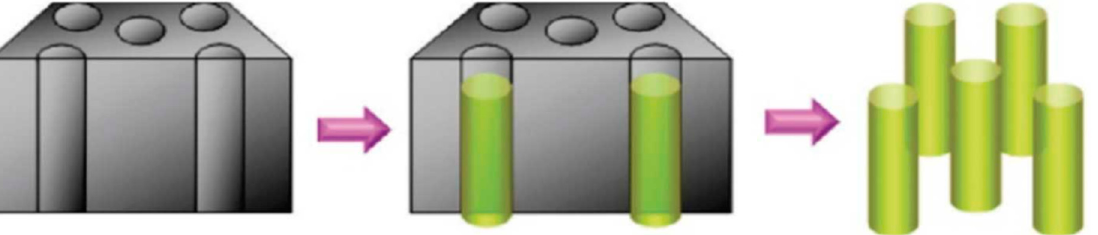
Figure 3. A schematic illustration of the growth process of nanowires via a hard template. Reproduced from Ref. [26] under the Creative Commons Attribution 4.0 International (CC BY 4.0) License.